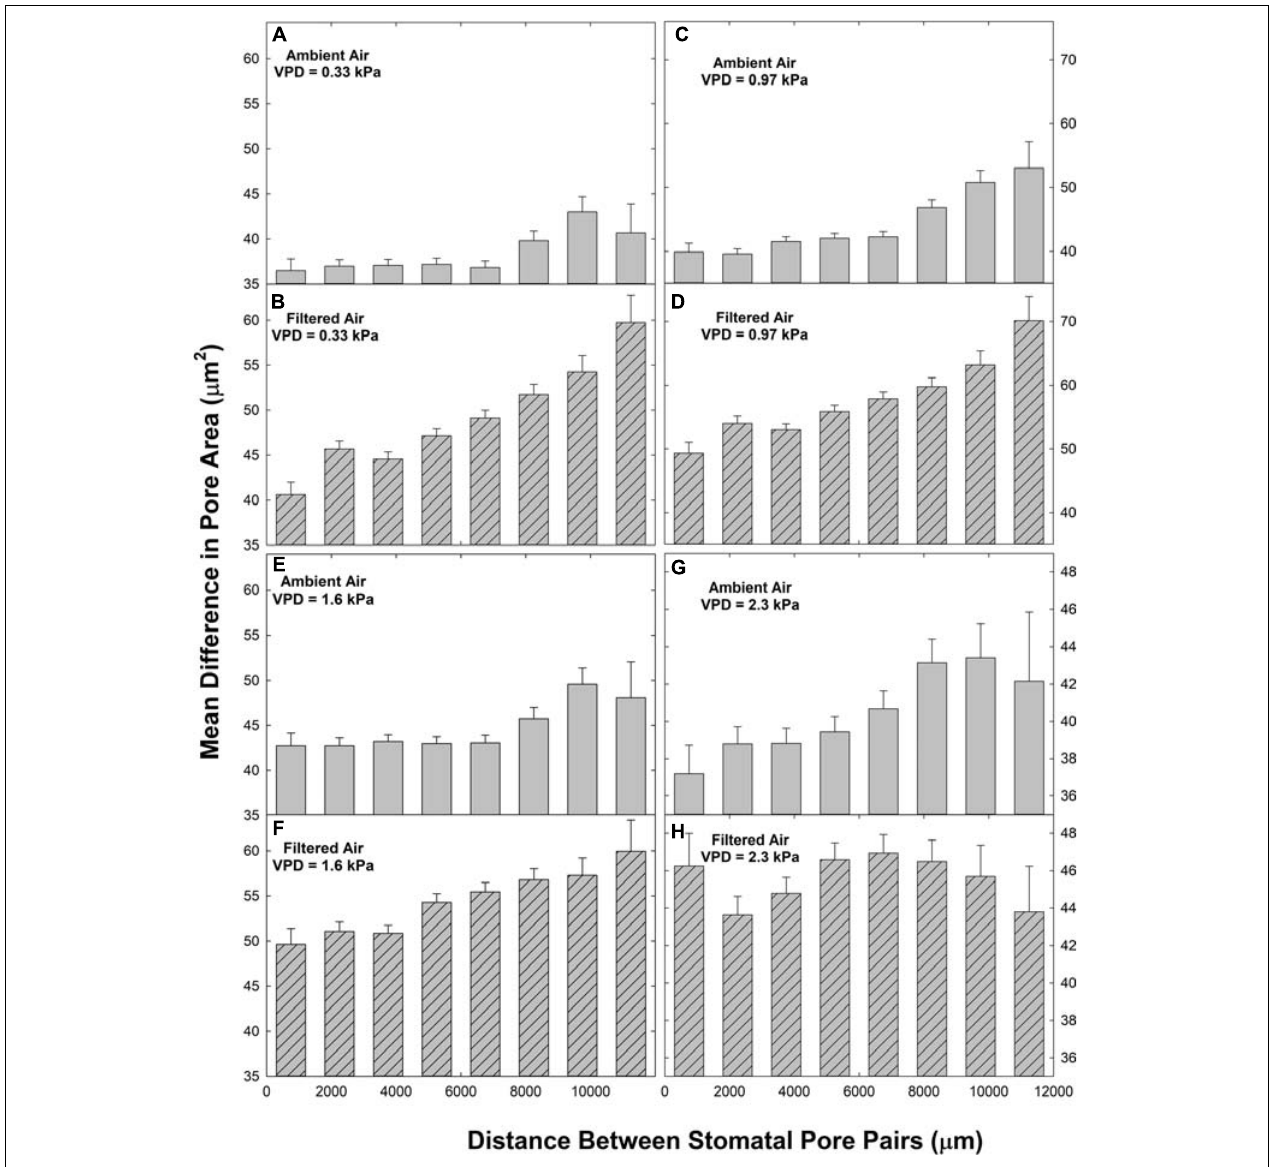
FIGURE 6 | Relationships between the paired difference between pore area ( (cid:49) A) and the distance separating the pores (d) in ambient air (AA; gray bars; A,C,E,G ) and filtered air (FA; hatched bars, B,D,F,H ) at different levels of evaporative demand (VPD), presented as mean ± s.e. Distance classes as in Figure 2 .